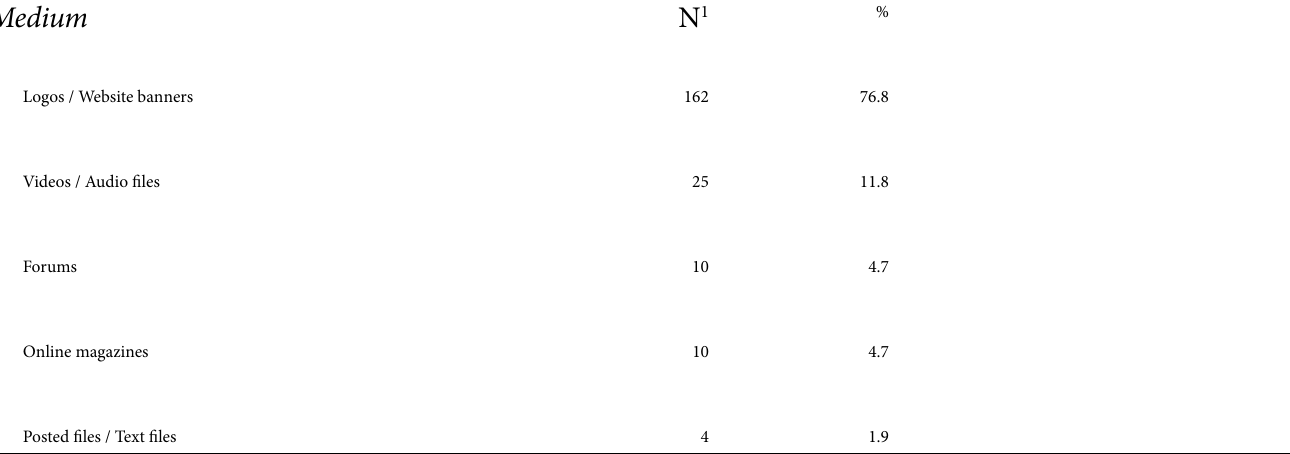
Table 1: Breakdown of analyzed digital media